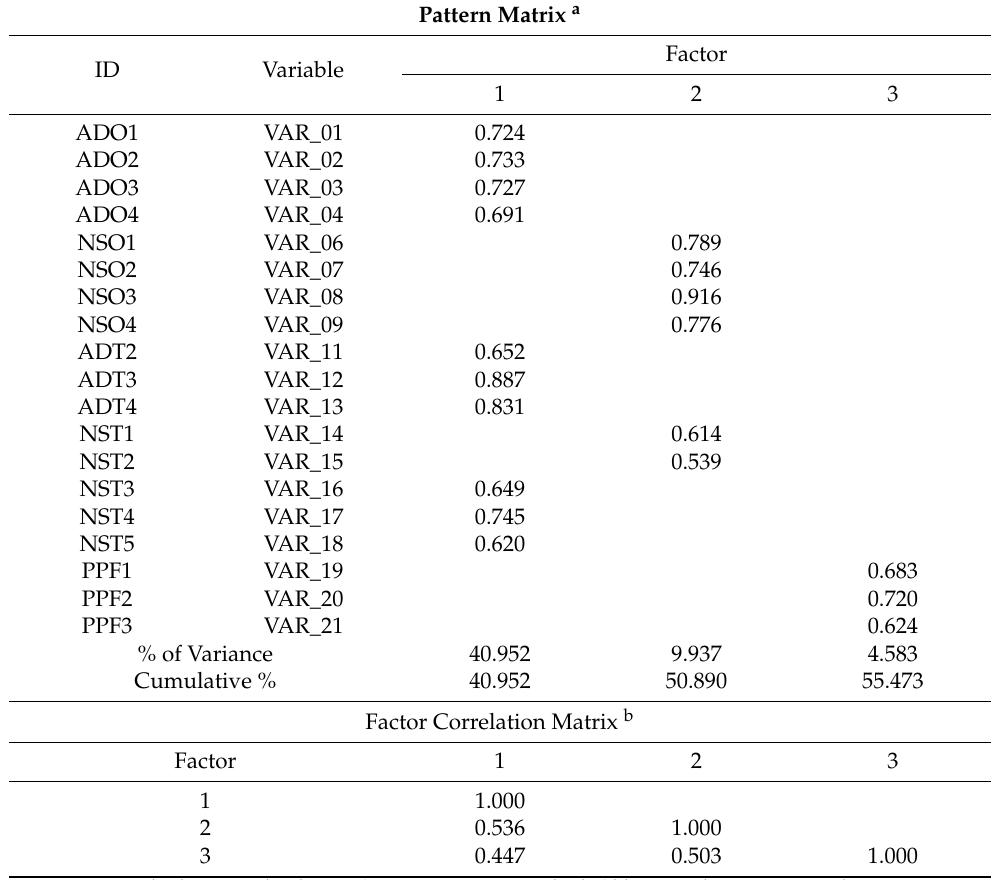
Table 6. Exploratory Factor Analysis for 3